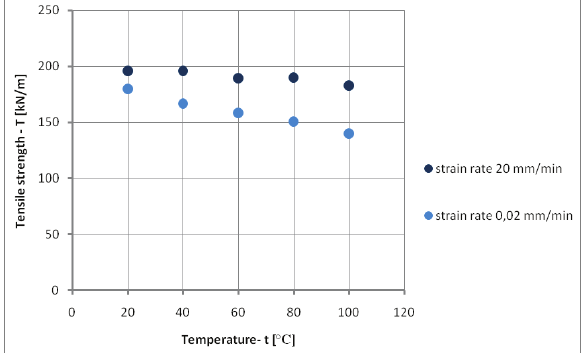
Fig. 3. Average value of maximum tensile strength of woven geotextile at 20 mm/min and 0.02 mm/min strain rate and temperature from 20 to 100 ° C